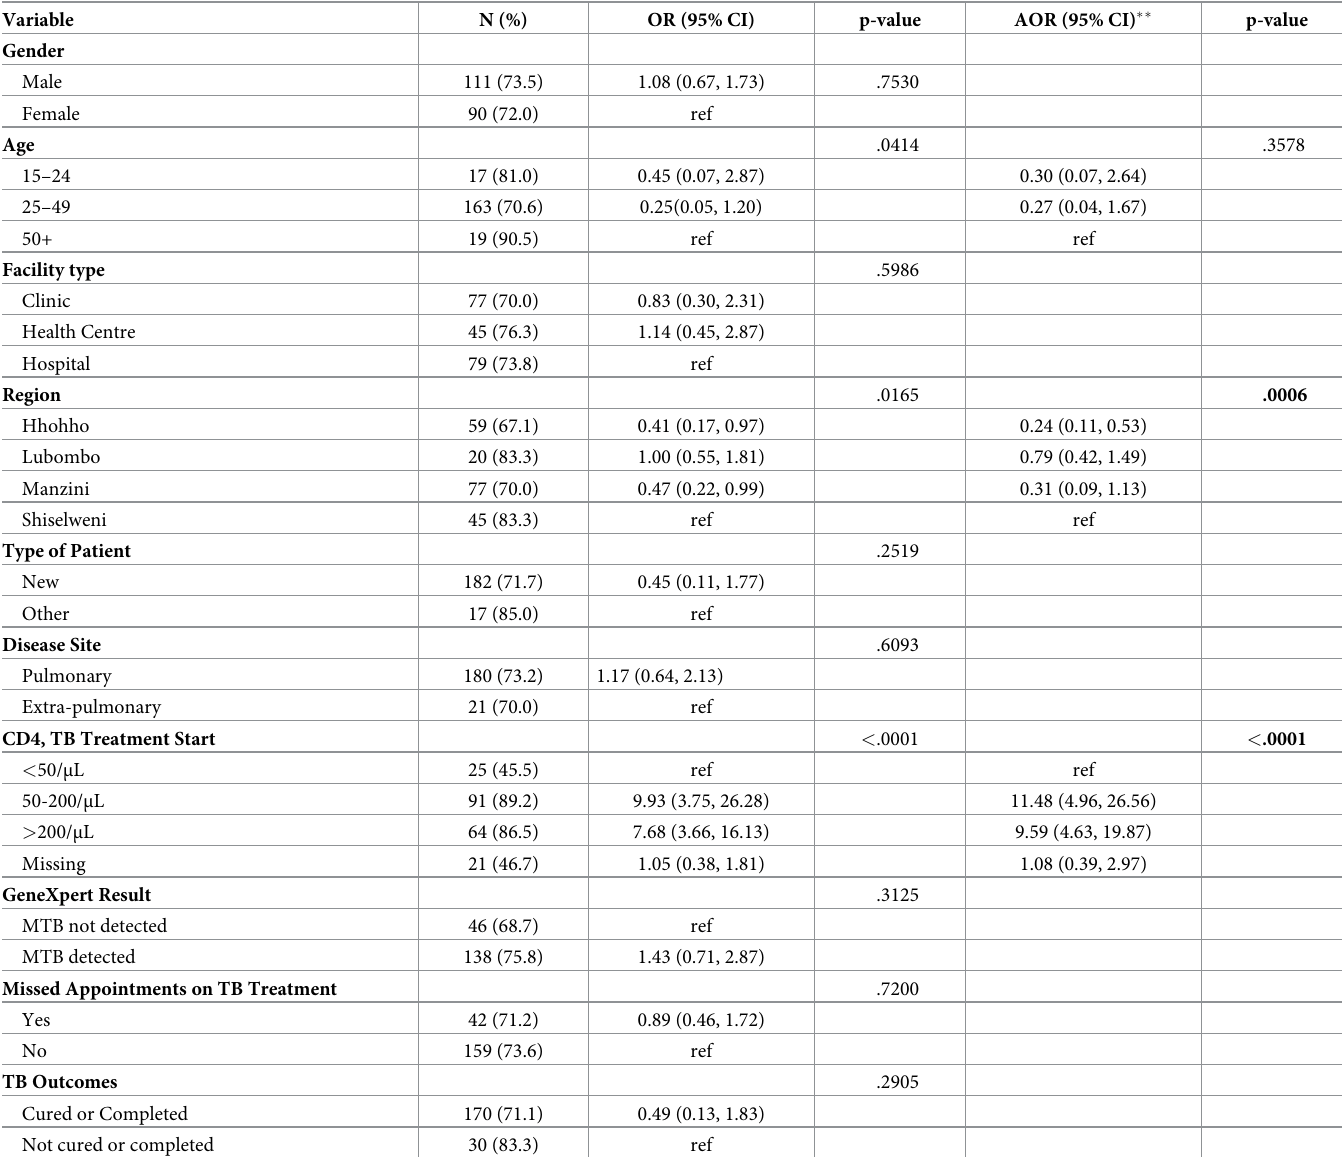
Table 3. Patient characteristics associated with timely (cid:3) ART for HIV+ TB patients not already on ART at TB treatment initiation (N = 276).